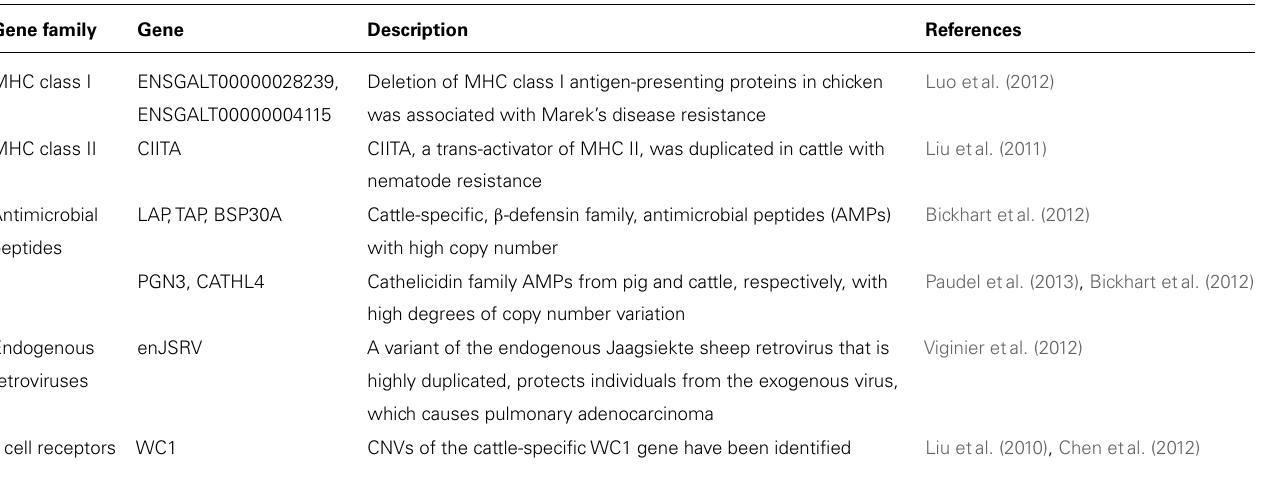
Table 2 | Immunity-related genes influenced by structural